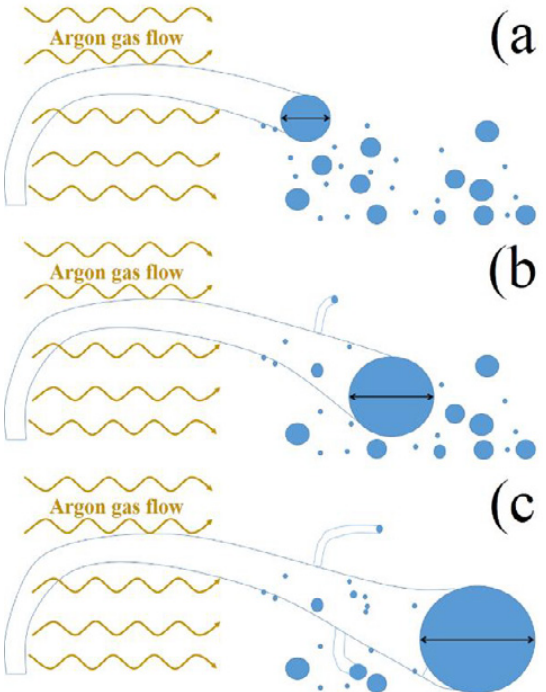
Fig. 11. The schematic of the effect of argon flow on the nanowires synthesized. (a) the argon flow resulted in the deviation of the wires, (b,c) the catalyst present at the wire tip combines with the catalyst droplets due to the deviation and